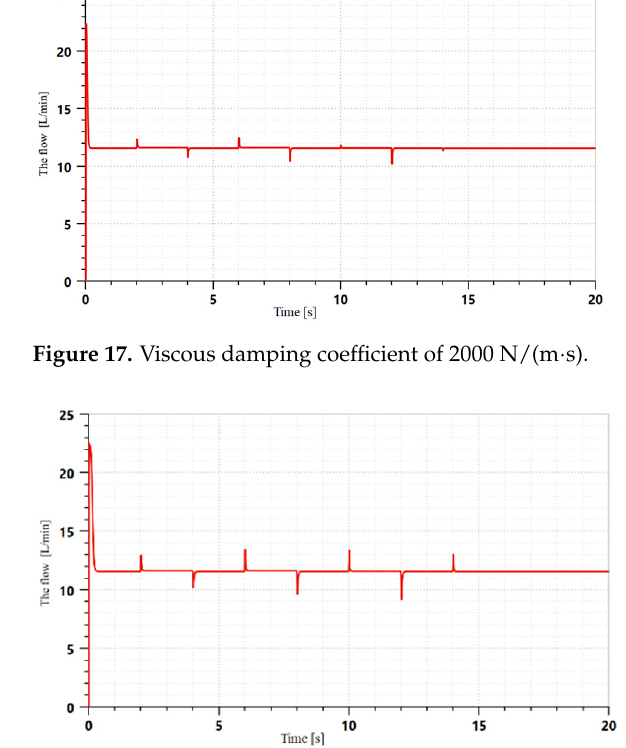
Figure 18. Viscous damping coefficient of 4000 N/(m·s).